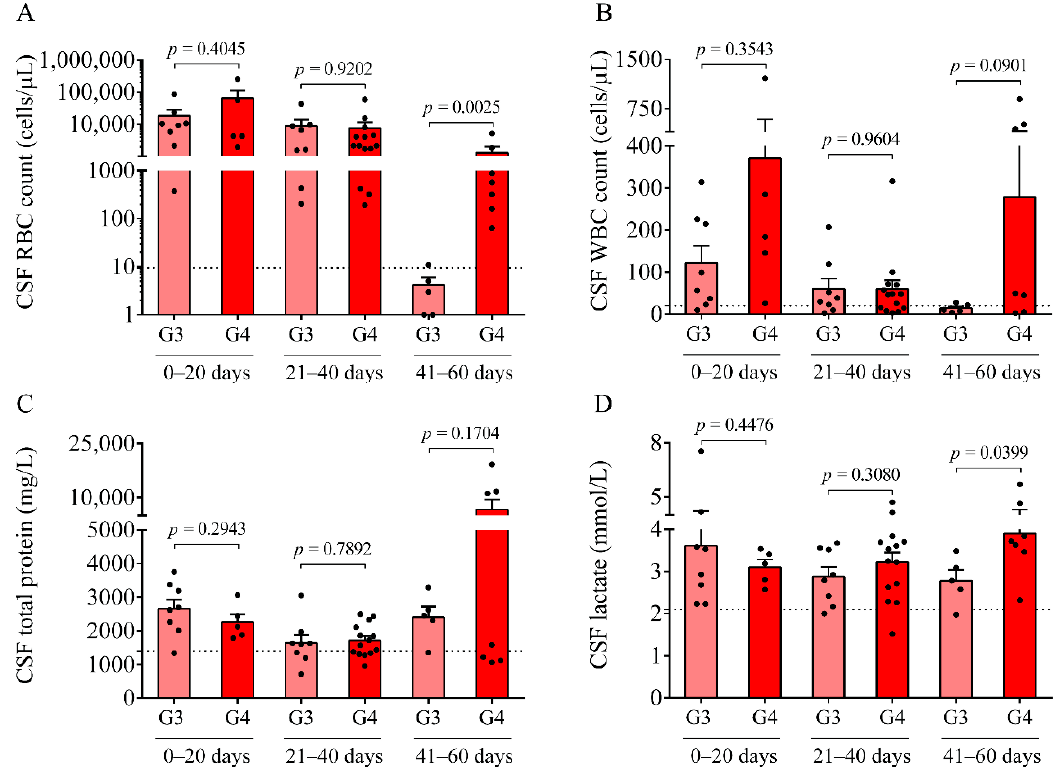
Figure 1. Comparison of routine laboratory parameters of Grade-III (G3, light red) and Grade-IV (G4, red) IVH groups at different time intervals after IVH onset. At 41–60 days, RBC count ( A ) and lactate concentration ( D ) were significantly elevated in the Grade-IV IVH group compared to the IVH-III group in the presence of a seemingly higher WBC count ( B ) and total protein ( C ) levels. Dots represent single values. Mean ± SEM are depicted. Dotted lines depict the mean value of the particular parameter measured in preterm non-IVH control samples [23]. To compare the data of the two groups, the Mann–Whitney U test or unpaired t -test was applied. Abbreviations: CSF, cerebrospinal fluid; G3, Grade-III IVH; G4,